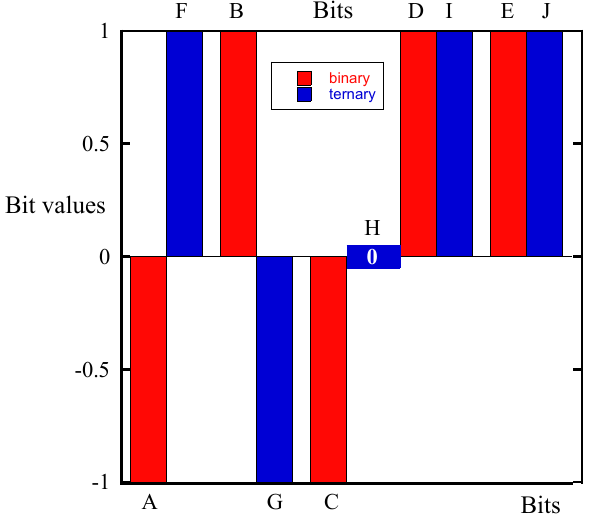
Figure 4. Joint plot of the binary and ternary fingerprints based on the source spectra shown in Figures 2 and 3.